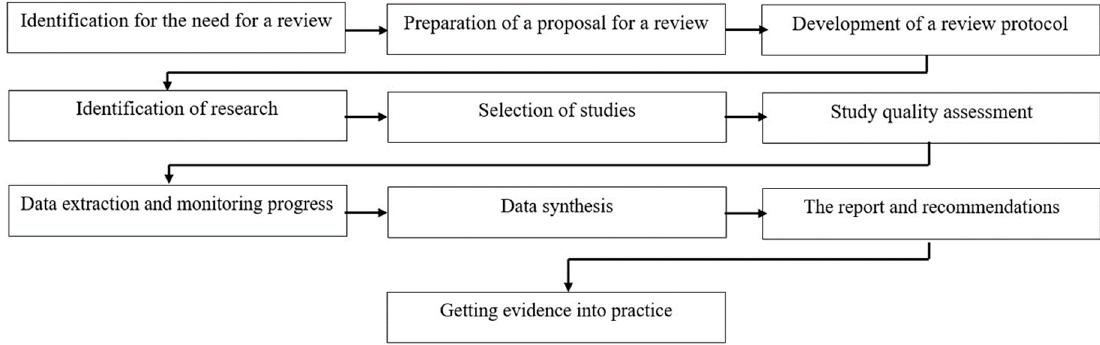
Figure 3. Stages of a systematic review. Source: Adapted from the research conducted in the NHS Center for Reviews and Dissemination by Bruce and Mollison (2004).